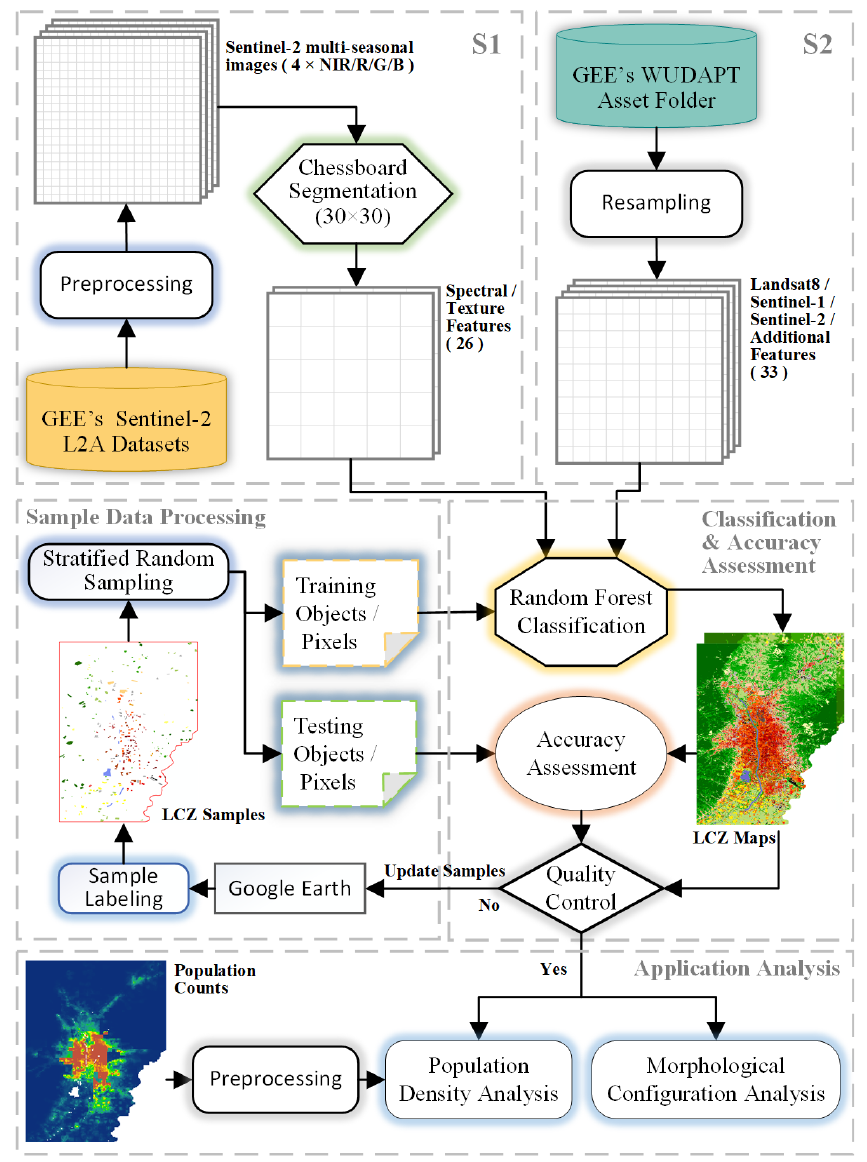
Figure 3. The workflow of LCZ classification method (S1 and S2), sample data processing, accuracy assessment, and application analysis.